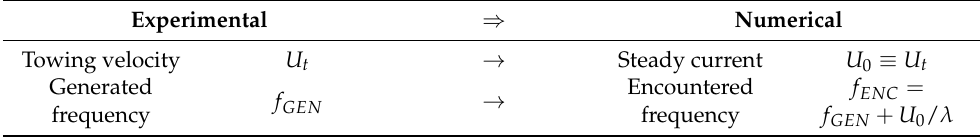
Table 3. Correspondence between the input of the experimental and numerical